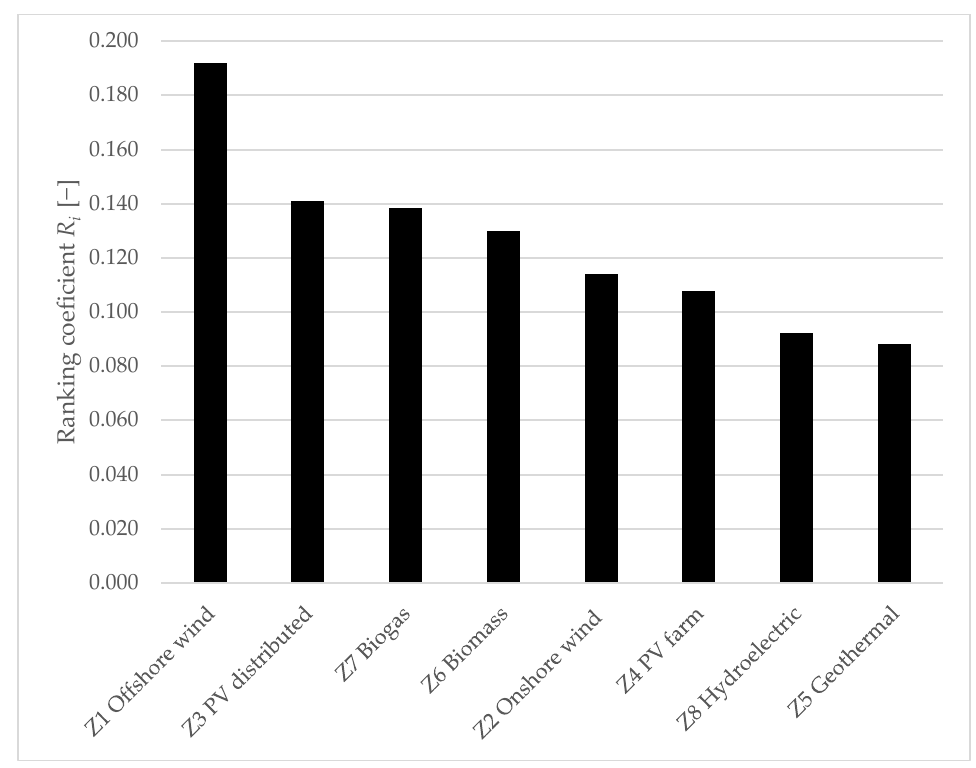
Figure 3. The values of the ranking coefficient presented in an ordered chart.